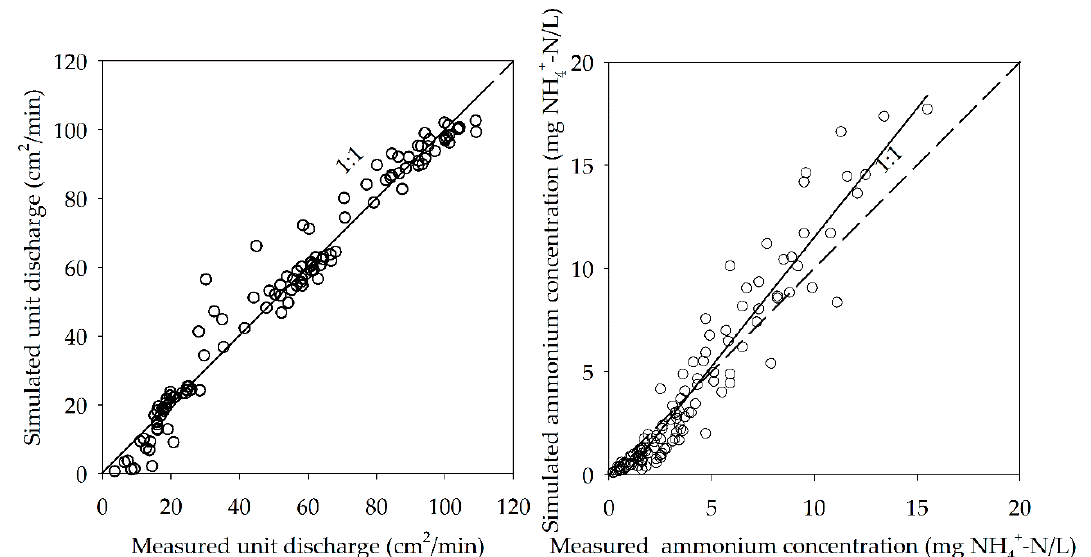
Figure 7. Simulated versus observed values for the unit discharge of runoff and the ammonium nitrogen (NH 4+ -N) concentration in runoff: ( a ) unit discharge of runoff, ( b ) ammonium nitrogen concentration in runoff.